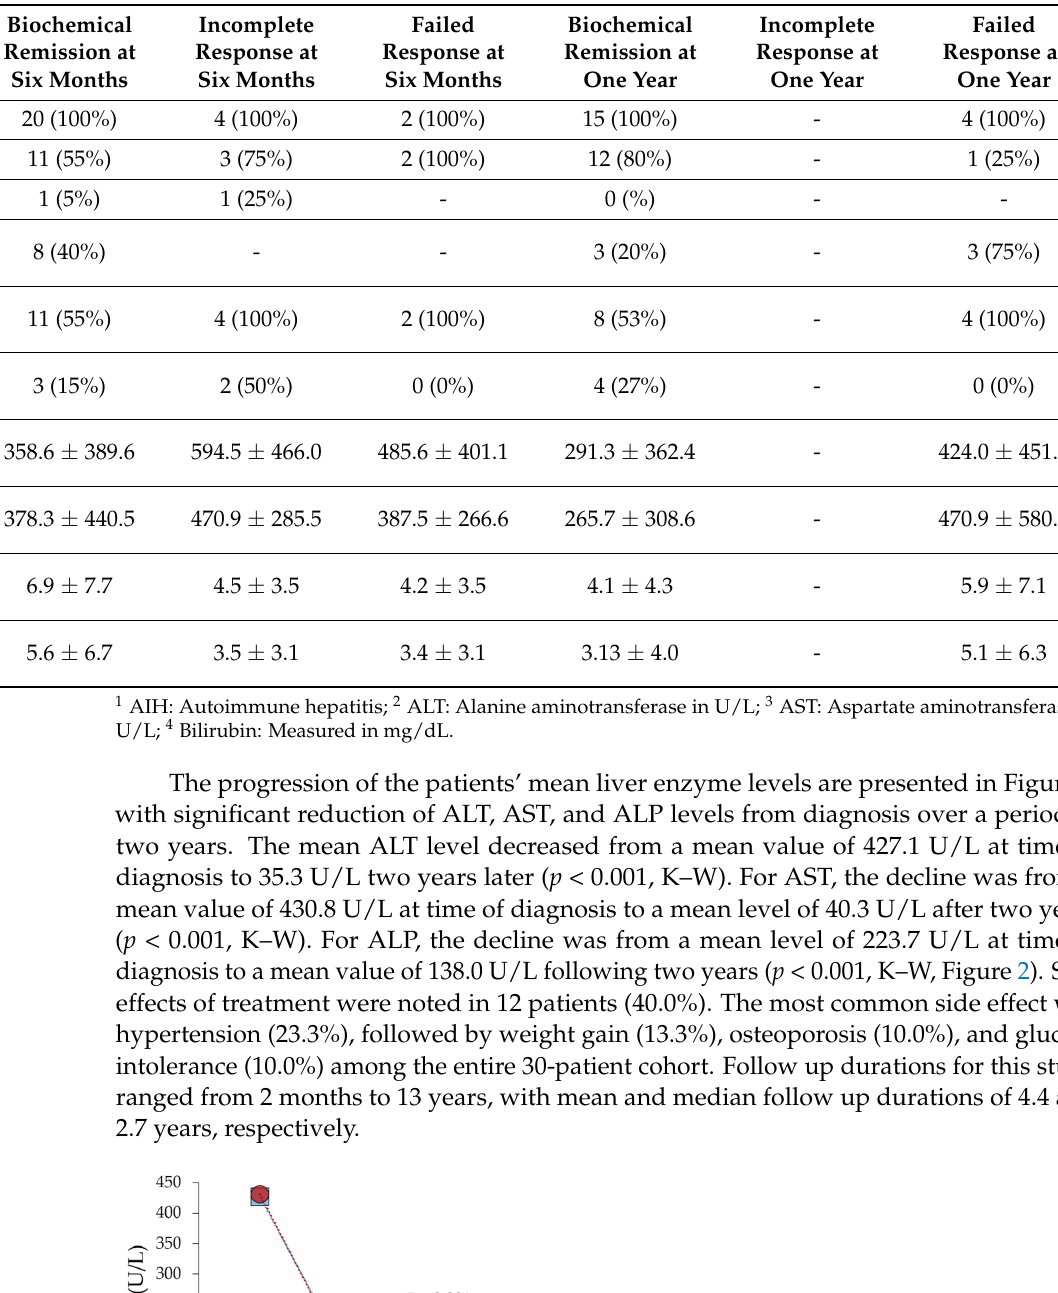
Table 3. Characteristics of the various laboratory panels at time of diagnosis stratified by autoimmune hepatitis (AIH) types in the study cohort.